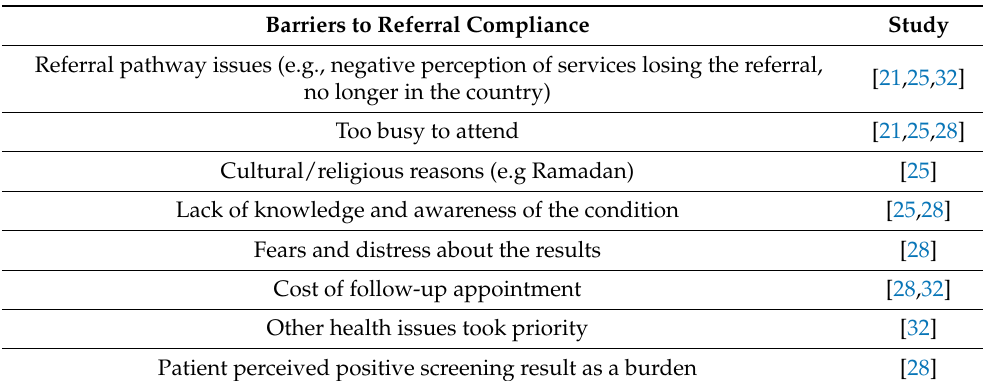
Table 2. Barriers to participants adhering to referral recommendation of the OHP. Barriers to Referral Compliance Study Referral pathway issues (e.g., negative perception of services losing the referral, no longer in the